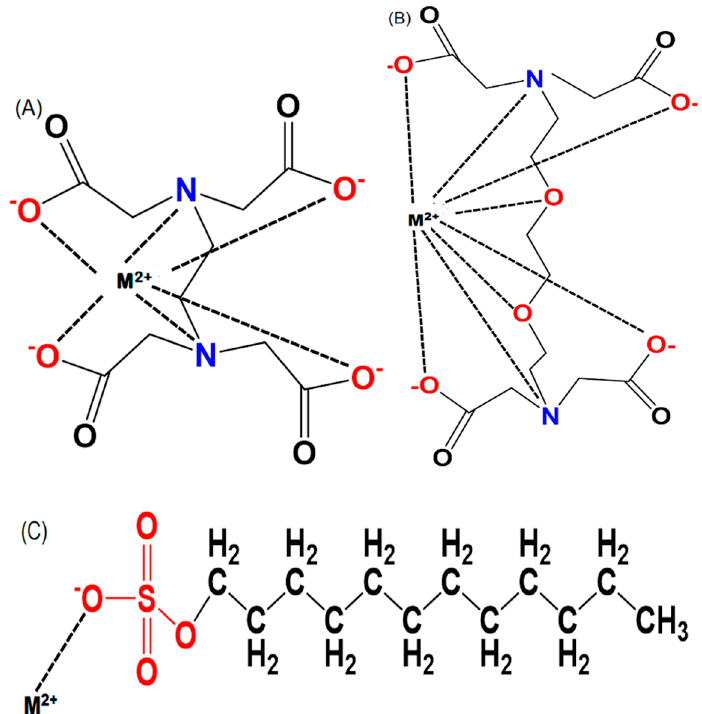
Figure 2. Chemical structure of ( A ) ethylene diamine tetraacetic acid (EDTA), ( B ) ethylene glycol tetraacetic acid (EGTA), ( C ) sodium dodecyl sulfate (SDS), and binding with metals, M 2+ (Cd 2+ , Pb 2+ etc.).